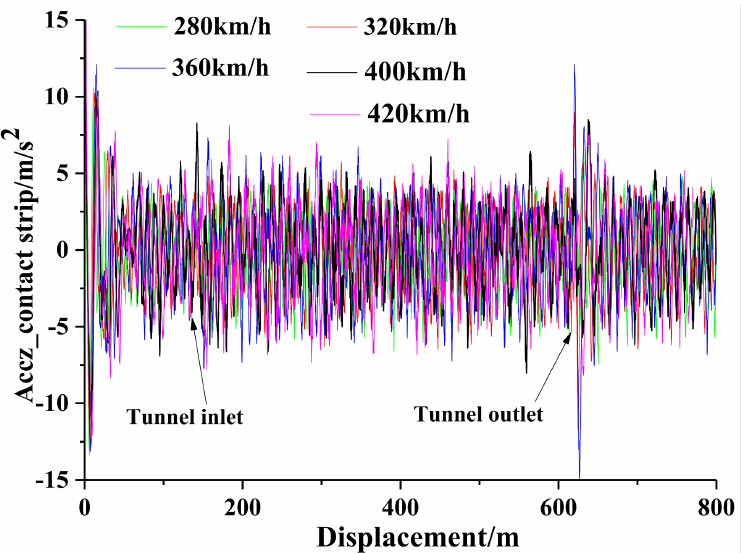
Figure 14. Comparison curves of vertical acceleration of the contact strip passing through tunnel at different